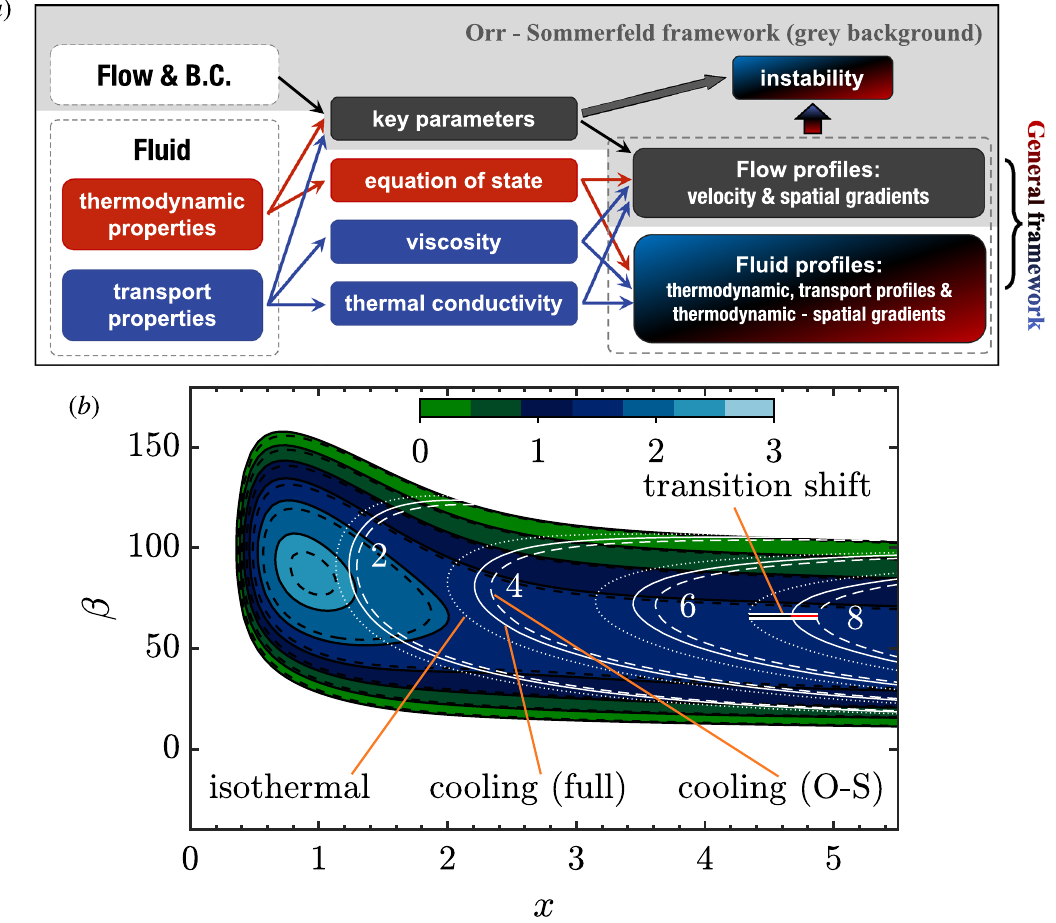
Figure 1. ( a ) An overview of essential inputs in building a general flow stability analysis framework. The grey background encircles the classic O–S framework, where only the Reynolds number and velocity profiles bear the physics. ( b ) Stability diagram for the steady cross-flow mode in the x − β frame. Spatial growth rates − α i (black lines) and N factors (white lines) are compared for the full (solid lines) and O–S (dashed lines)